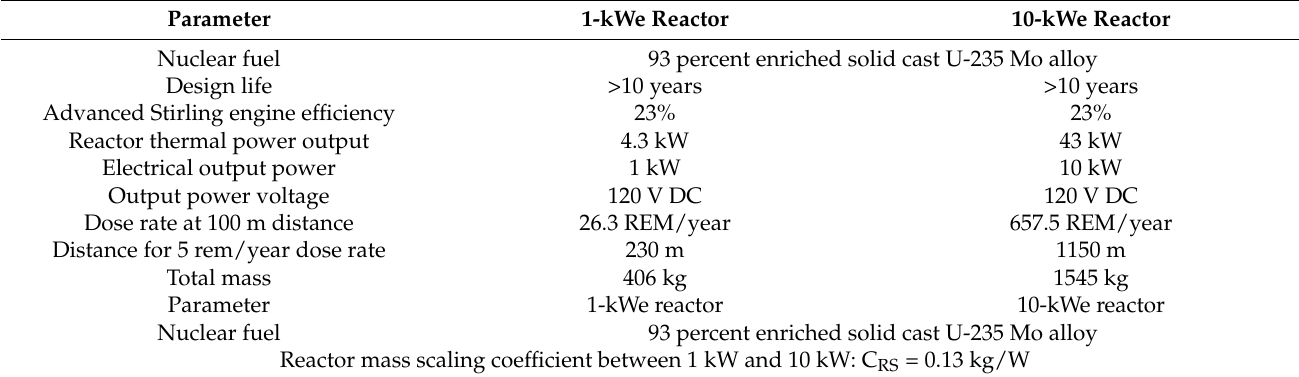
Table 7. Kilopower Reactor Using Stirling Technology (KRUSTY) reactor